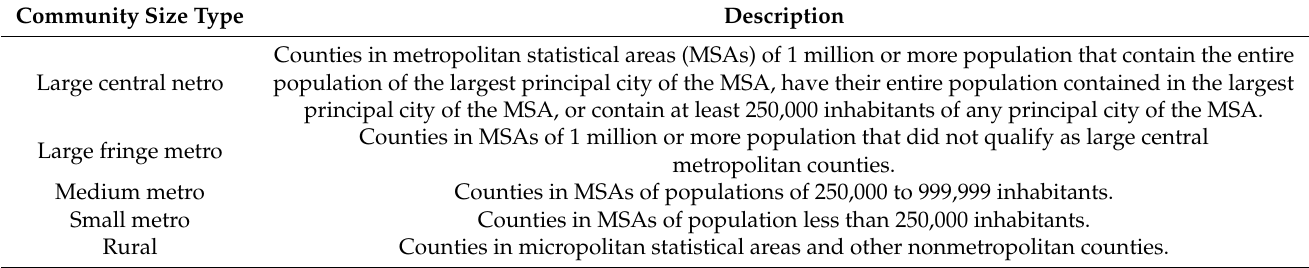
Table 1. Summary of community population sizes evaluated in this study. Community Size Type